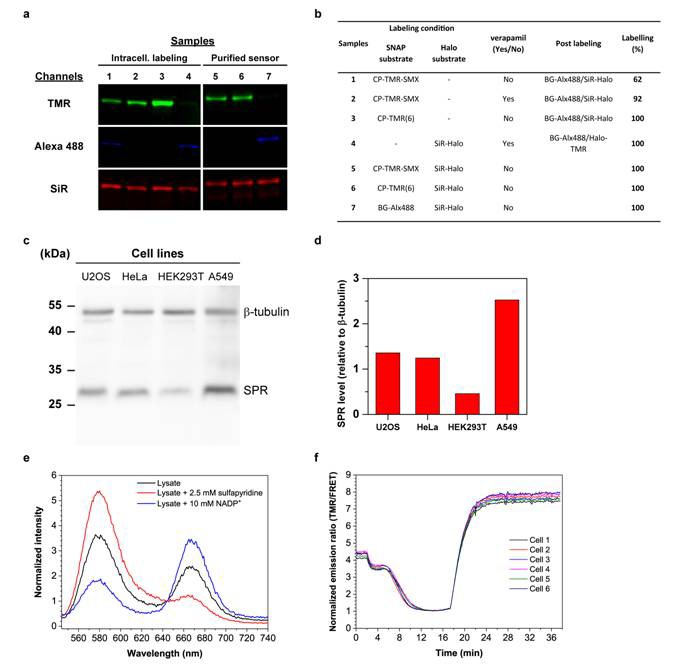
In cellulo sensor characterization.Intracellular labeling efficiencies. (a) Representative in-gel fluorescence detection of intracellular and in vitro (control) sensor protein labeling. The sensor protein is labeled intracellularly (U2OS cells) with CP-TMR-SMX, CP-TMR(6) or SiR-Halo (samples 1–4) with or without the presence of the efflux pump inhibitor verapamil (10 µM), overnight. The cells were washed and lysed with an excess BG-Alexa(488) and SiR-Halo or Halo-TMR to quantify the unlabeled fraction of SNAP-tag and Halo-tag. As control the purified sensor was labeled in vitro with CP-TMR-SMX/CP-TMR(6)/BG-Alexa(488) and SiR-Halo (samples 5–7). For the quantification of TMR or SiR labeling, the ratio of Alexa(488)/SiR and TMR/SiR of the intracellular samples is calculated relative to the in vitro samples. The results of the labeling efficiency and the description of the samples run on the SDS-PAGE gel can be found in Table b. (c) Comparison of the endogenous SPR level of different cell lines by Western Blot. Western blot of SPR (28 kDa) and β-tubulin (50 kDa) as loading control with different cell lysates revealed by ECL. For each cell lysates, 20 µg total protein were loaded in each well. (d) Representation of the relative expression level of SPR in the different cell lines determined as integrated band intensity normalized to β-tubulin integrated intensity using the displayed blot. (e) The sensor dynamic range is maintained in lysate or in cells. The purified NADP-Snifit is added to a freshly prepared U2OS lysate (0.5 mg/mL protein) to a concentration of 50 nM. The measured TMR/SiR ratio of 1.6 corresponds to a NADPH/NADP+ ratio of 11 in the whole-cell lysate (black line). The sensor was fully open by adding a saturating concentration of free ligand (2.5 mM sulfapyridine) and displays a TMR/SiR ratio of 4.5 (red line). To obtain the fully closed sensor in lysate, 10 mM NADP+ was spiked to the lysate, resulting in a TMR/SiR ratio of 0.5 (blue line). A similar FRET ratio change can be observed for closed sensor in buffer. (f) Semi-stable U2OS cells expressing the nuclear localized NADP-Snifit were used to performed an intracellular sensor calibration. The cells plated on a 12-well plate poly-L-lysine coated coverslip were imaged in HBSS with a widefield microscope. After 2 min, 10 mM NADP+ and 0.001% (w/w) digitonin prepared in HBSS was added to reach the sensor closed state. At 17 min, sulfapyridine was added to a saturating concentration (2 mM) to reach the sensor open state. The dynamic range measured with this widefield microscope was approximately of 8-fold similarly to lysate and buffer measurements.10.7554/eLife.32638.031Appendix 1—figure 3—source data 1.10.7554/eLife.32638.032Appendix 1—figure 3—source data 2.